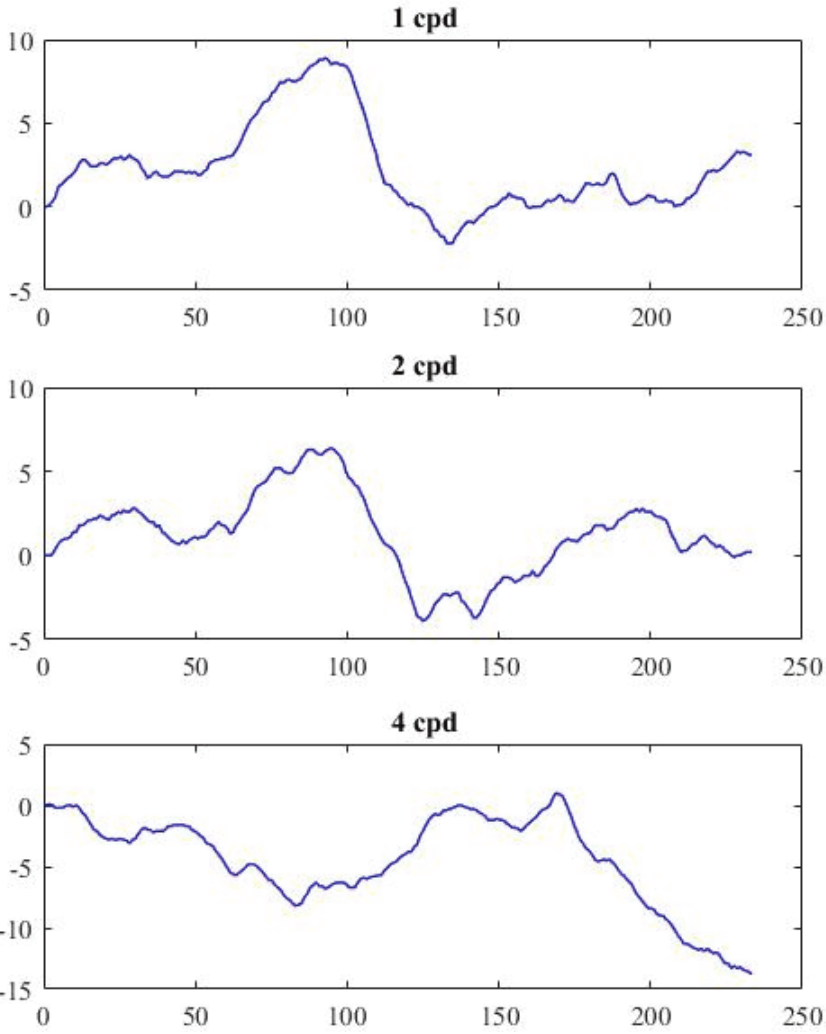
Figure 1. Pattern-reversal visual evoked potentials for one participant at 1, 2, and 4 cpd in the time